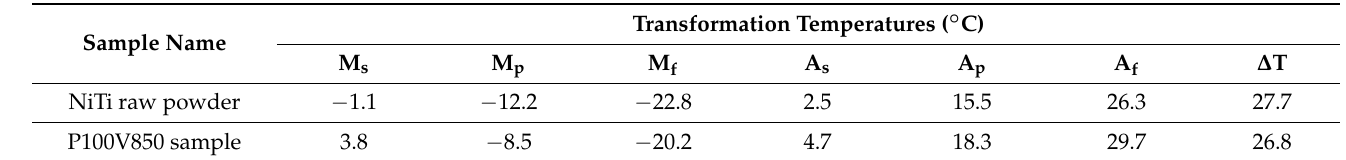
Figure 12. Differential scanning calorimetry for raw powder and sample P100V850. Table 2. Temperatures of phase martensitic transition of initial powder material and fabricated sample.